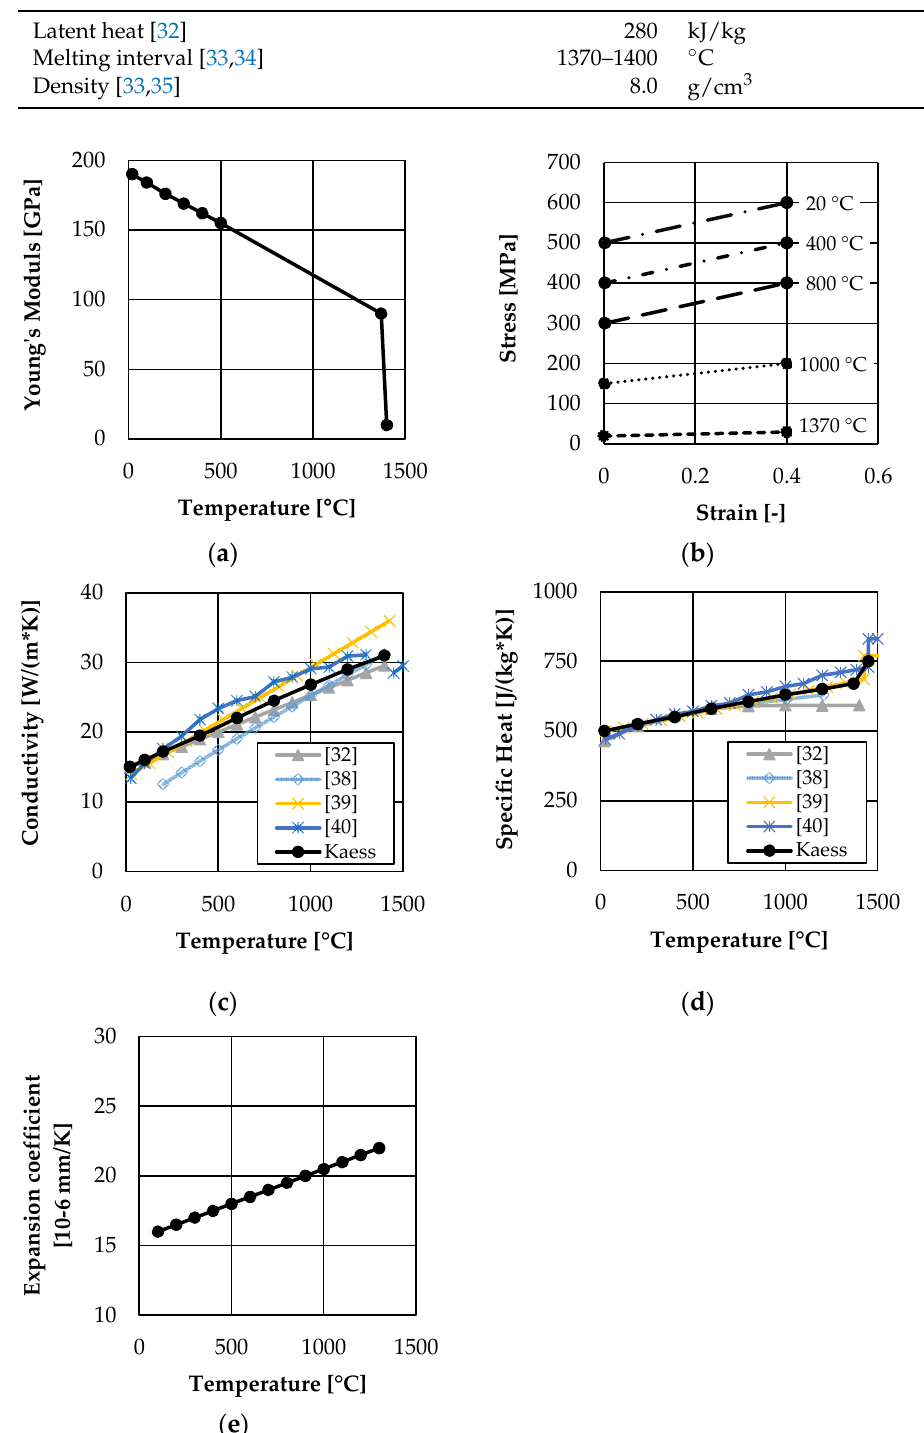
Figure 4. Temperature dependent material properties of 316L: ( a ) Young’s Modulus (value at room temperature [33] vertical; slope from 100 °C to 500 °C [36,37]; values at melting temperature: as- sumption) ( b ) Flow curve (values at room temperature [33] vertical – rounded; values at higher temperatures: assumption) ( c ) Thermal conductivity (derived from [32,37–40]) ( d ) Specific heat (de- rived from [32,37–40]) ( e ) Thermal expansion (values up to 500 °C [36,37]; values from 500°C: slope assumed according to [39]).